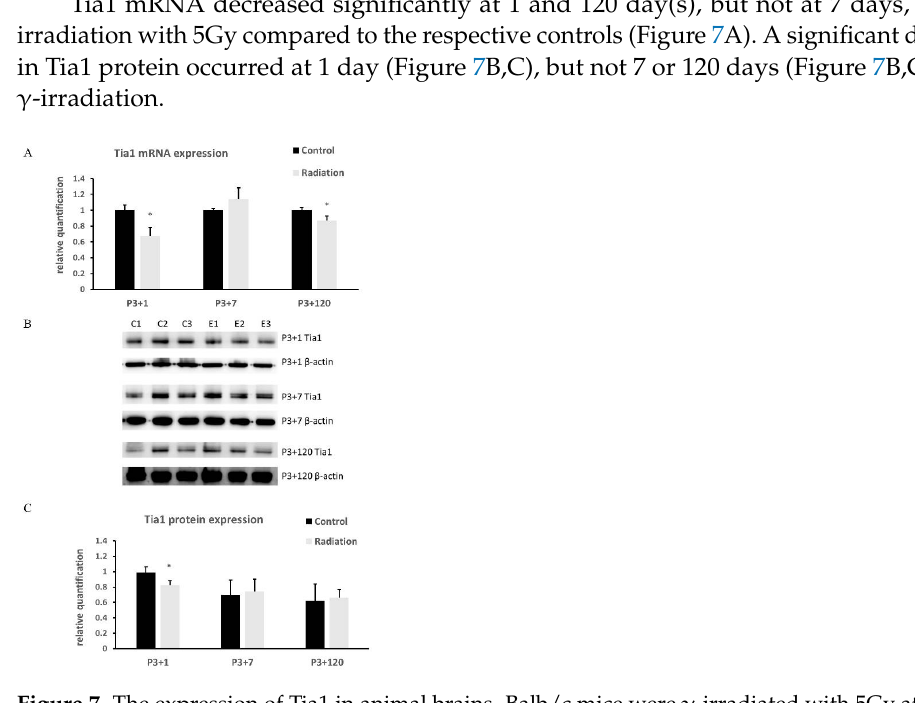
Figure 7. The expression of Tia1 in animal brains. Balb/c mice were γ-irradiated with 5Gy at P3, and brain samples were collected at 1, 7, and 120 day(s) after irradiation. ( A ) mRNA expression of Tia1 by qRT-PCR; ( B ) western blot images of Tia1; ( C ) statistical results of Tia1 protein levels. Data are expressed as mean ± SEM (n = 3). * p < 0.05 vs respective control. 3.6. Γ-Irradiation Increased the Expression of miR-34a-5p in NSCs and Decreased the mRNA Expression of Tia1